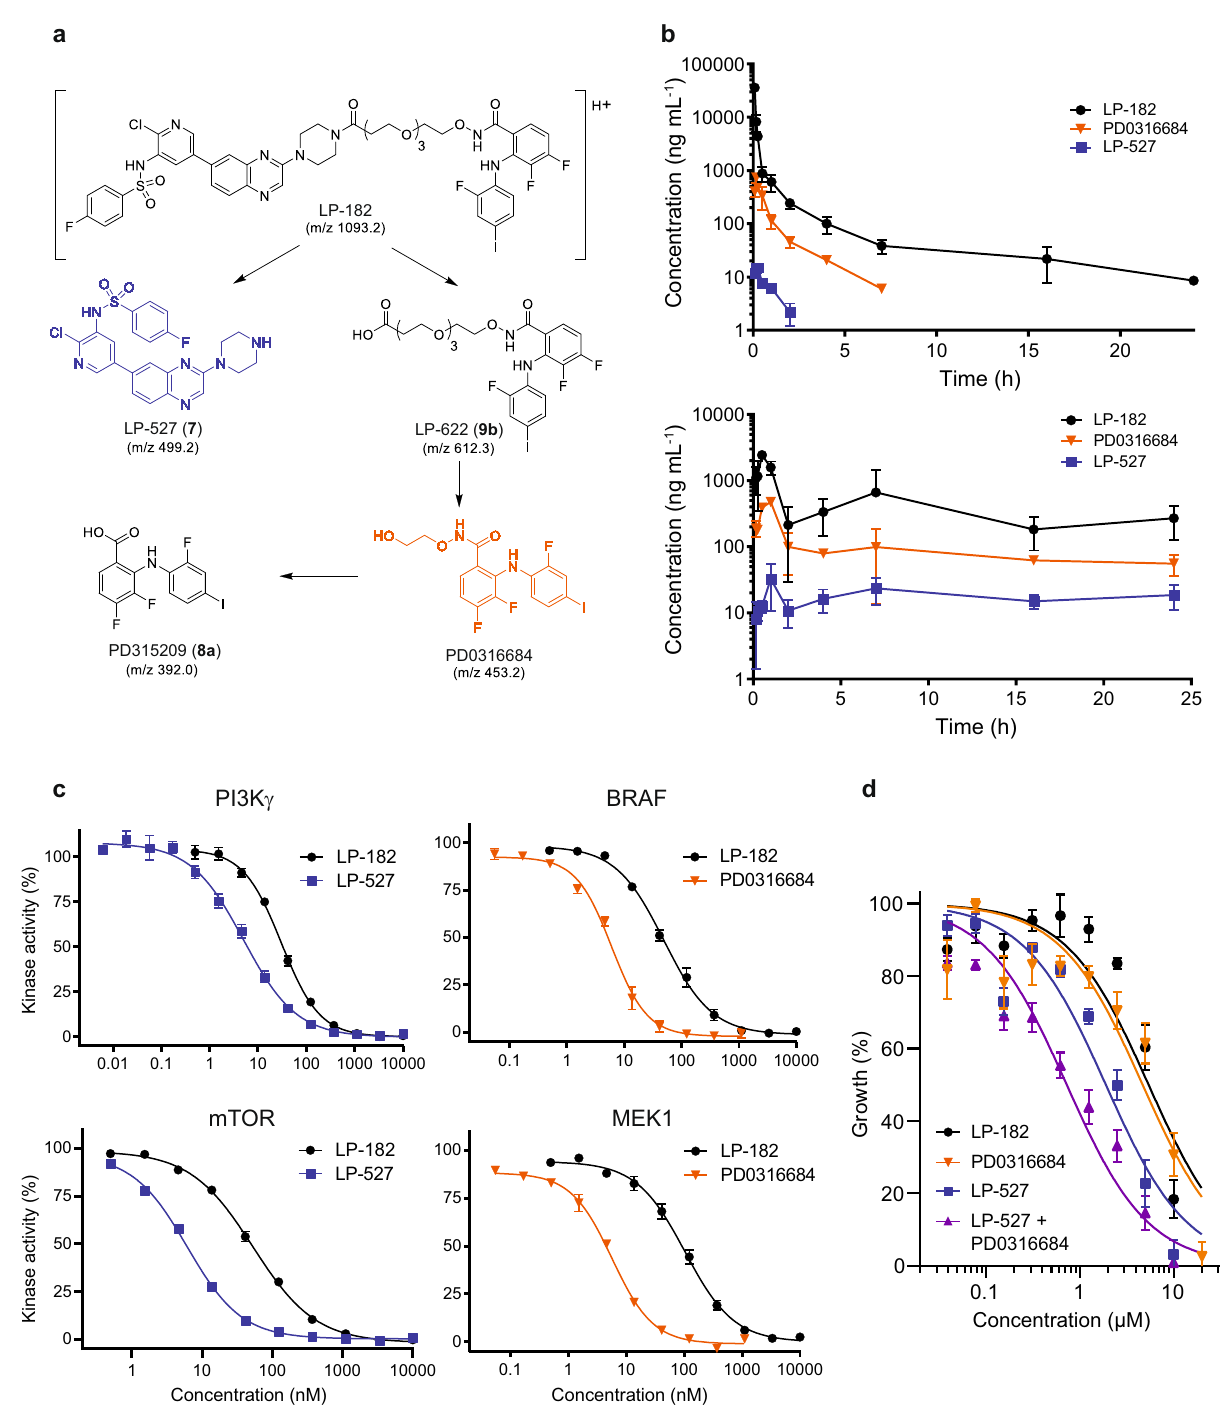
Fig. 2 | In vivo pharmacokinetics upon oral administration achieves sustained levels of LP-182 and potent biologically active metabolites. a LP-182 in vivo metabolic degradation products. b In vivo pharmacokinetics of LP-182 and asso- ciatedmetabolites in mice following a singleintravenous (15mgkg − 1 ; top panel) or oral (400mgkg − 1 ; bottom panel) dose of LP-182. Data represent the mean±s.d., n =3 animals sampled per time point per compound dosing. Source data are pro- vided as a Source Data fi le. c Target kinase (PI3K γ , mTOR, BRAF, MEK1) 10-point inhibition assays against LP-182, LP-527, or PD0316684 at the indicated con- centrations. Data represent the mean±s.e.m., LP-182 ( n =5, PI3K γ ; n =3, mTOR; n =3, BRAF; n =5, MEK1; independent experiments performed in replicate), LP-527